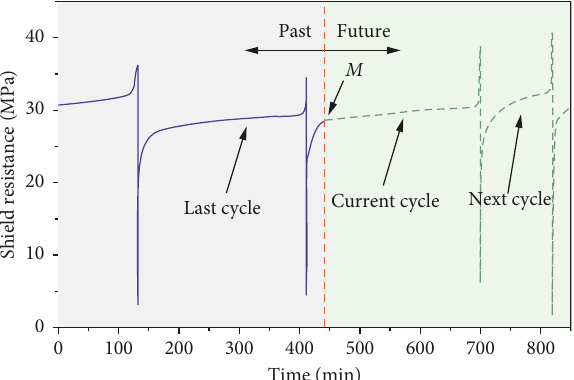
Figure 14: Temporal-evolution of shield resistance denoting early warning of periodic roof